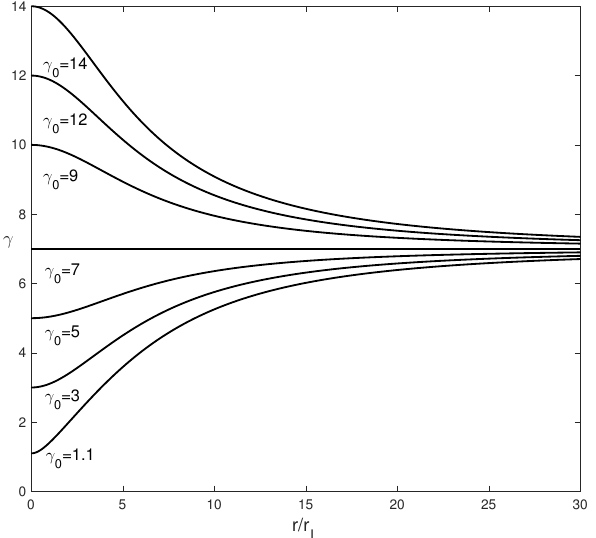
Figure 3. The dependence of the Lorentz factor on the radial coordinate for different initial relativistic factors γ 0 .The calculations are done for an Archimedean spiral with the critical Lorentz factor γ cr = 7. All particles are launched from r 0 = 0. As is evident from the plot, the curve γ cr attracts all other curves. The figure is taken from